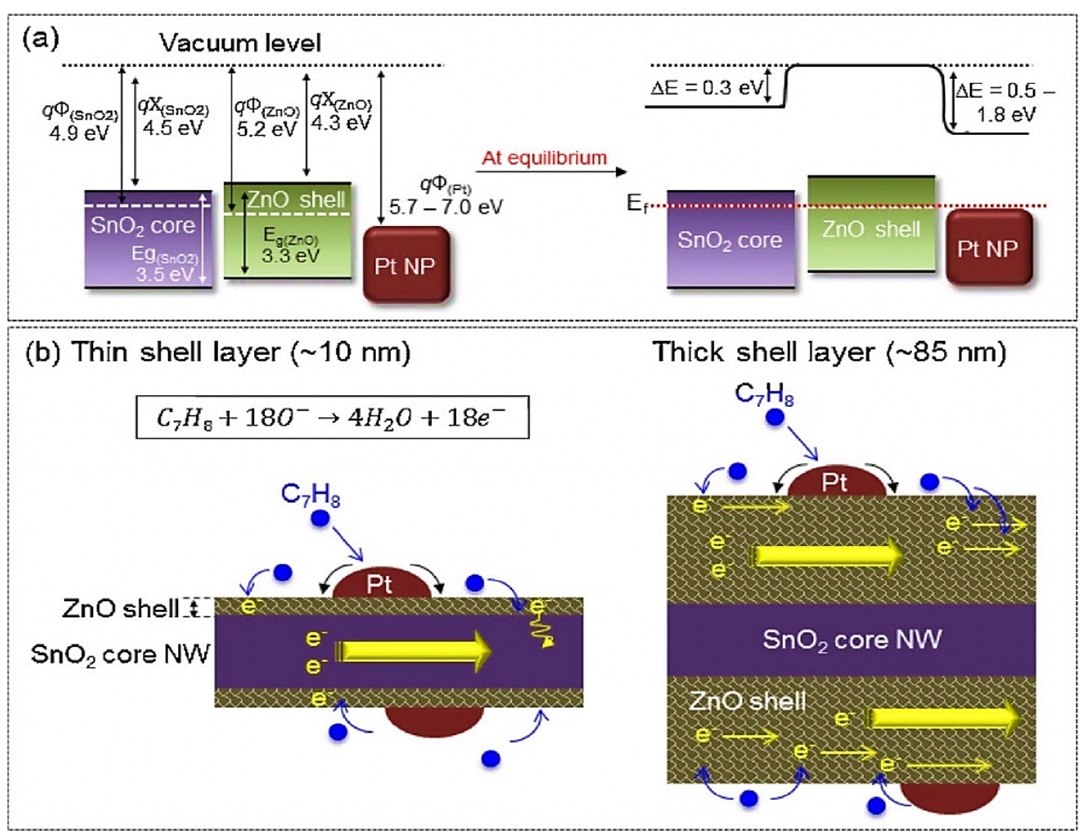
Figure 20. Schematic of C 6 H 6 gas-sensing mechanisms of Pt-functionalized SnO 2 -ZnO C-S NWs. ( a ) Energy band diagrams and ( b ) Pt catalytic effect on different shell thicknesses. Reproduced from [112] with the permission of Elsevier.